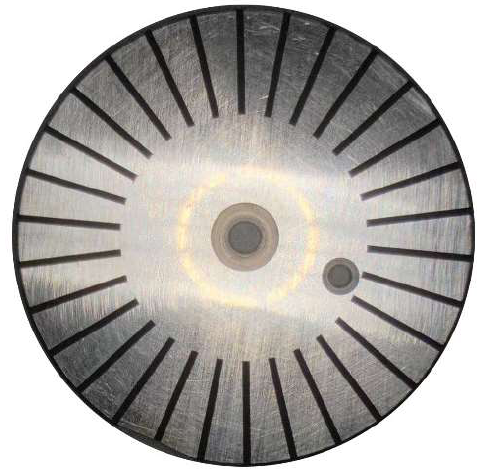
Figure 3. Femtosecond texture. The friction characteristics of micromechanical groove texture on 0Cr17Ni7Al surface were experimentally studied using friction and wear testbed (MFT-5000). The testing machine is shown in Figure 4, with the relevant parameters of the test piece shown in Table 3.